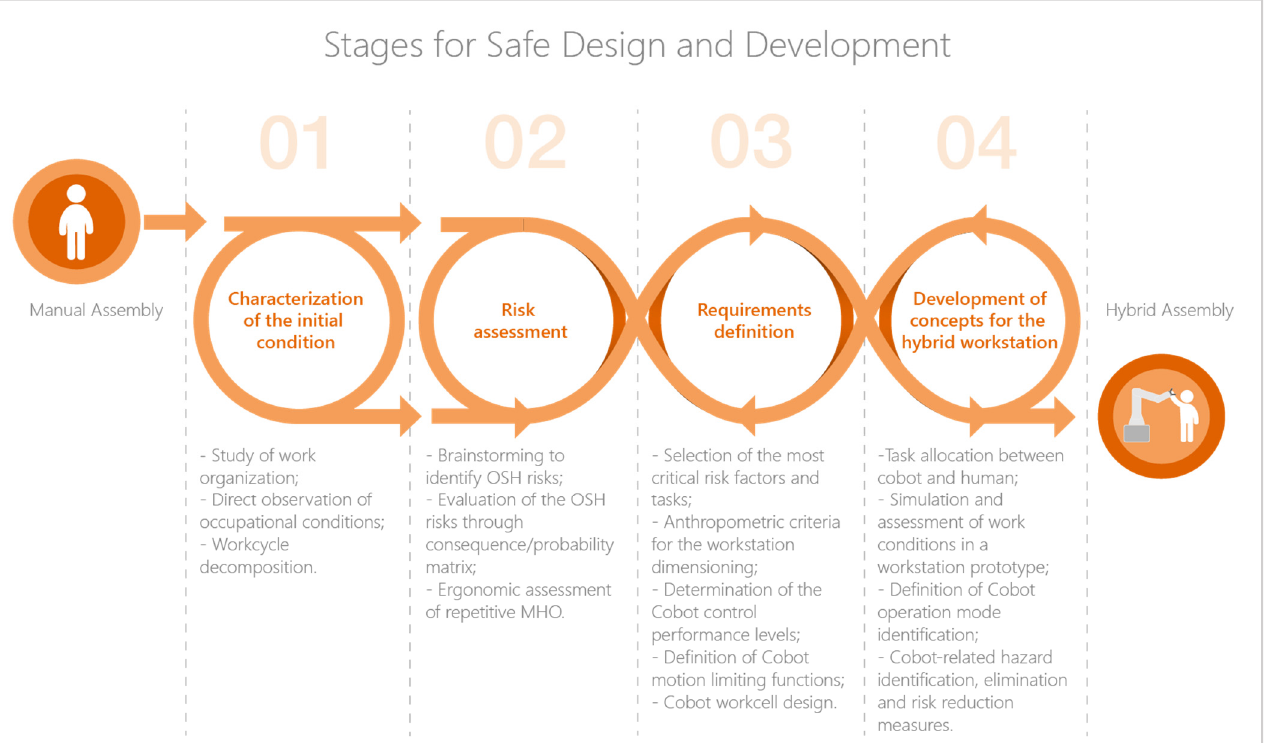
Figure 2. Framework adopted in the case study.